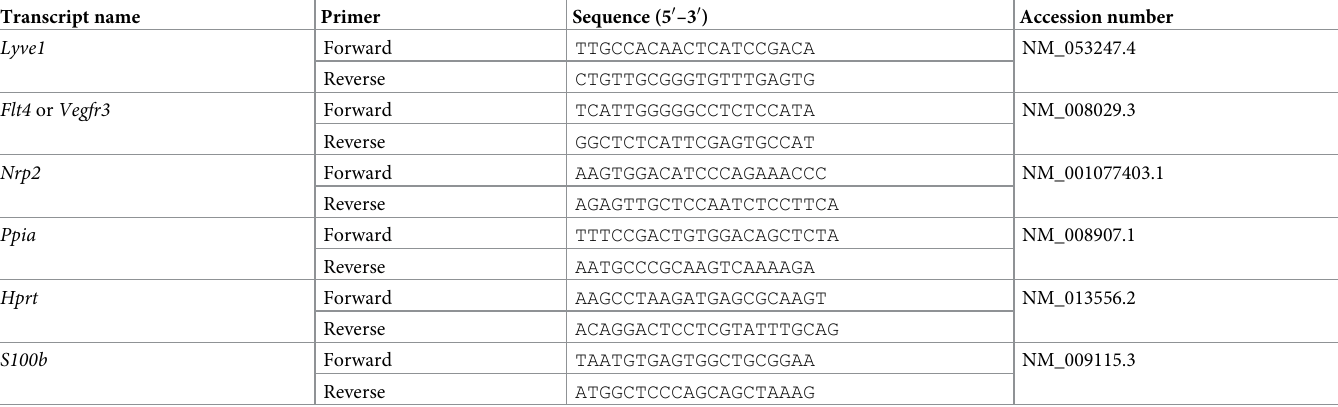
Table 1. Sequences of the primers used for